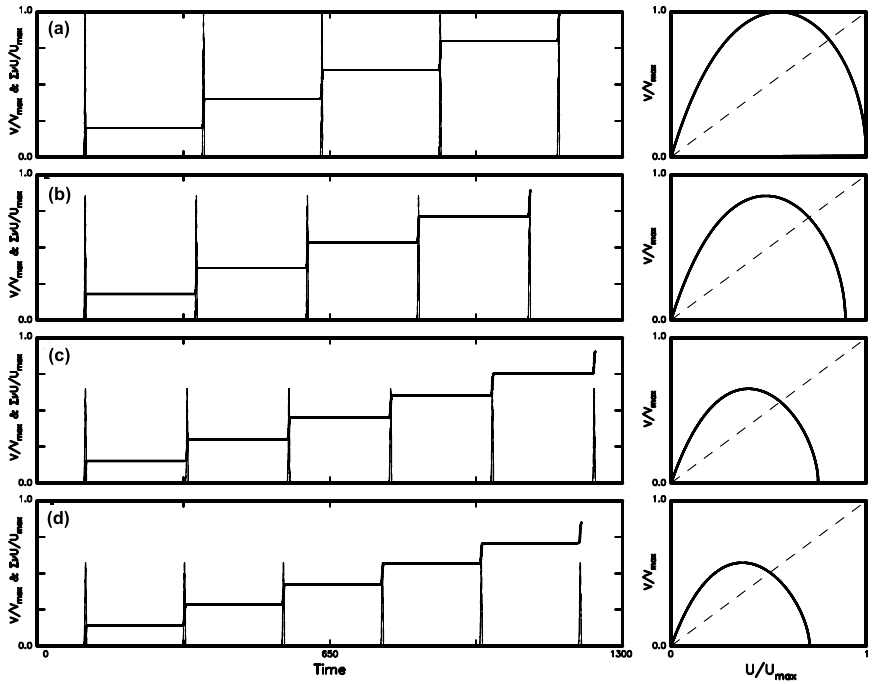
Figure 5. The time variations in V/V max (thin solid line) and cumulative slip (cid:54)U/U max (solid line) and the phase portrait of V/V max versus U/U max (solid line) for four values of η : (a) for η = 0.2; (b) for η = 0.4; (c) for η = 0.8; and (d) for η = 1.0 when U c =